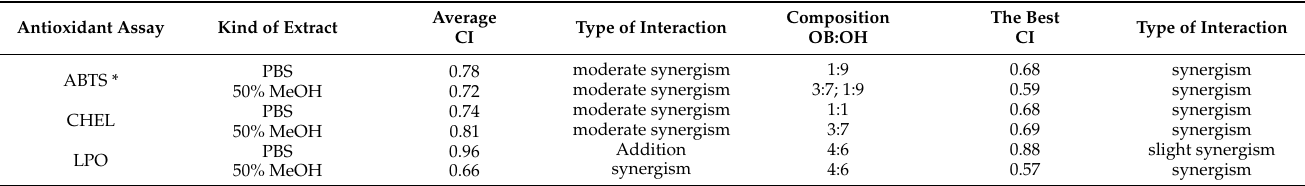
Table 4. The Best Connections OB:OH for The Tested Antioxidant Activities, Combination Index (CI), and The Type of